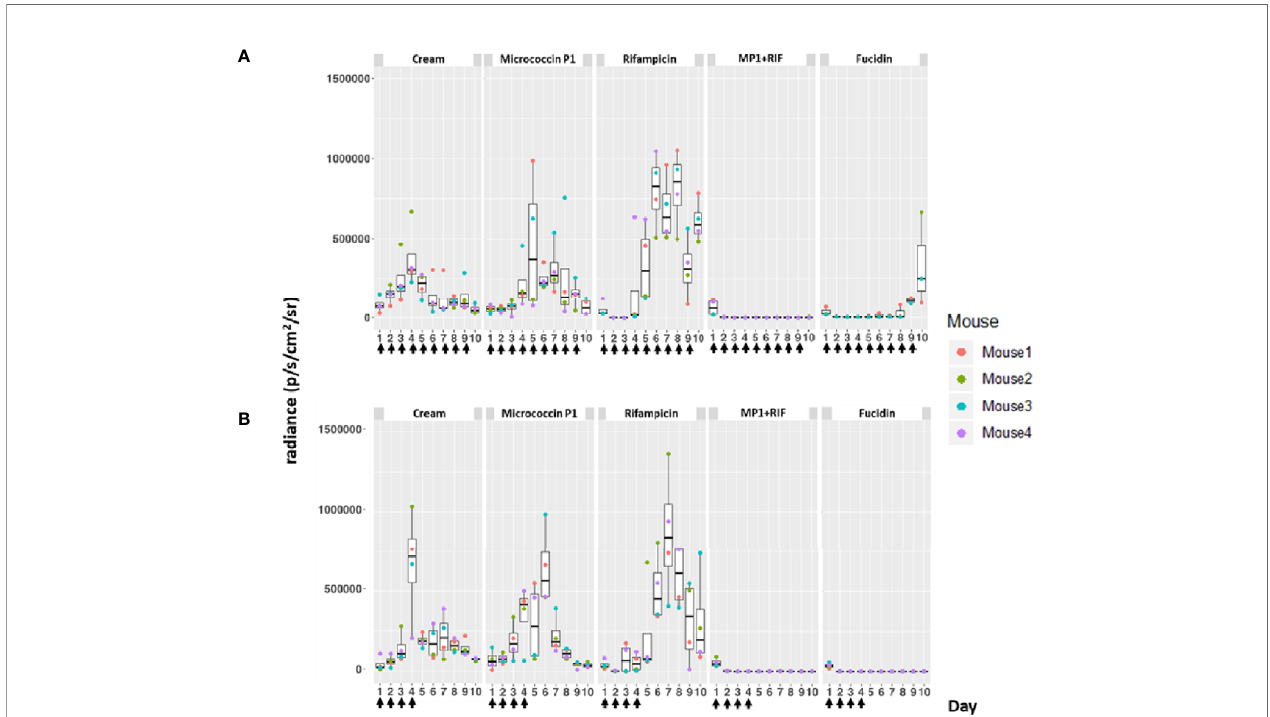
FIGURE 4 | Bioluminescence from mice skin infections during different treatments. Box plots of bioluminescent signals produced by MRSA Xen31 (in photons per second per square centimeter per steradian) in differently treated mouse groups. The days of treatment are indicated with arrows. (A) mice received daily treatments for nine days. (B) mice received daily treatments for four days before they were left untreated for the rest of the experiment. The area within each box represents the interquartile region (IQR), which comprises the second and third quartiles and describes the interval of values where the middle 50% of the observed data are distributed. The horizontal black line within each box represents the median value. The extent of the IQR (box height) express the degree of variability measured within the middle 50% of the observed data, with whiskers extending out at either side of the boxes marking the minimum and maximum observed values, as well as the variability outside the middle 50% of values (whisker length). Outliers are displayed as data that extend out of the whisker limit (1.5 times the